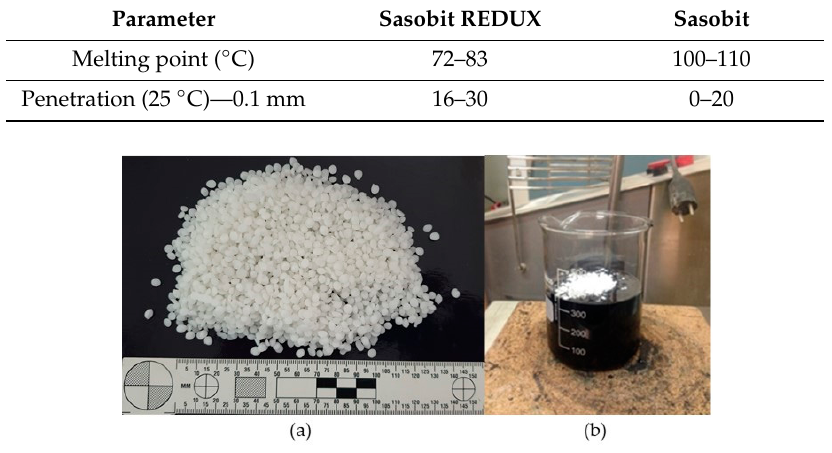
Figure 3. Sasobit REDUX ( a ) pastilles, ( b ) addition to bitumen.